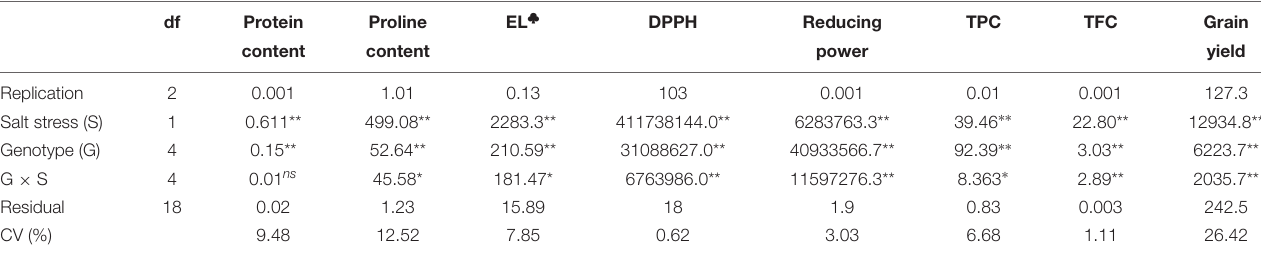
TABLE 1 | Results of analysis of variance for the biochemical properties and grain yield of the genotypes studied under the control and salt stress conditions. df Protein Proline EL ♣ DPPH Reducing TPC